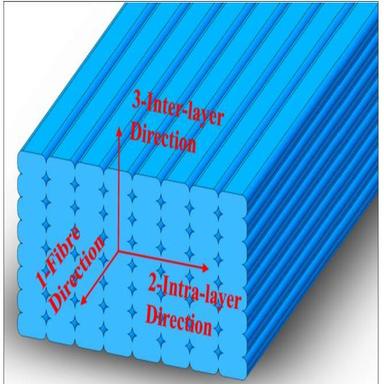
3D micro-structure model of FFF 3D printing PLA material.